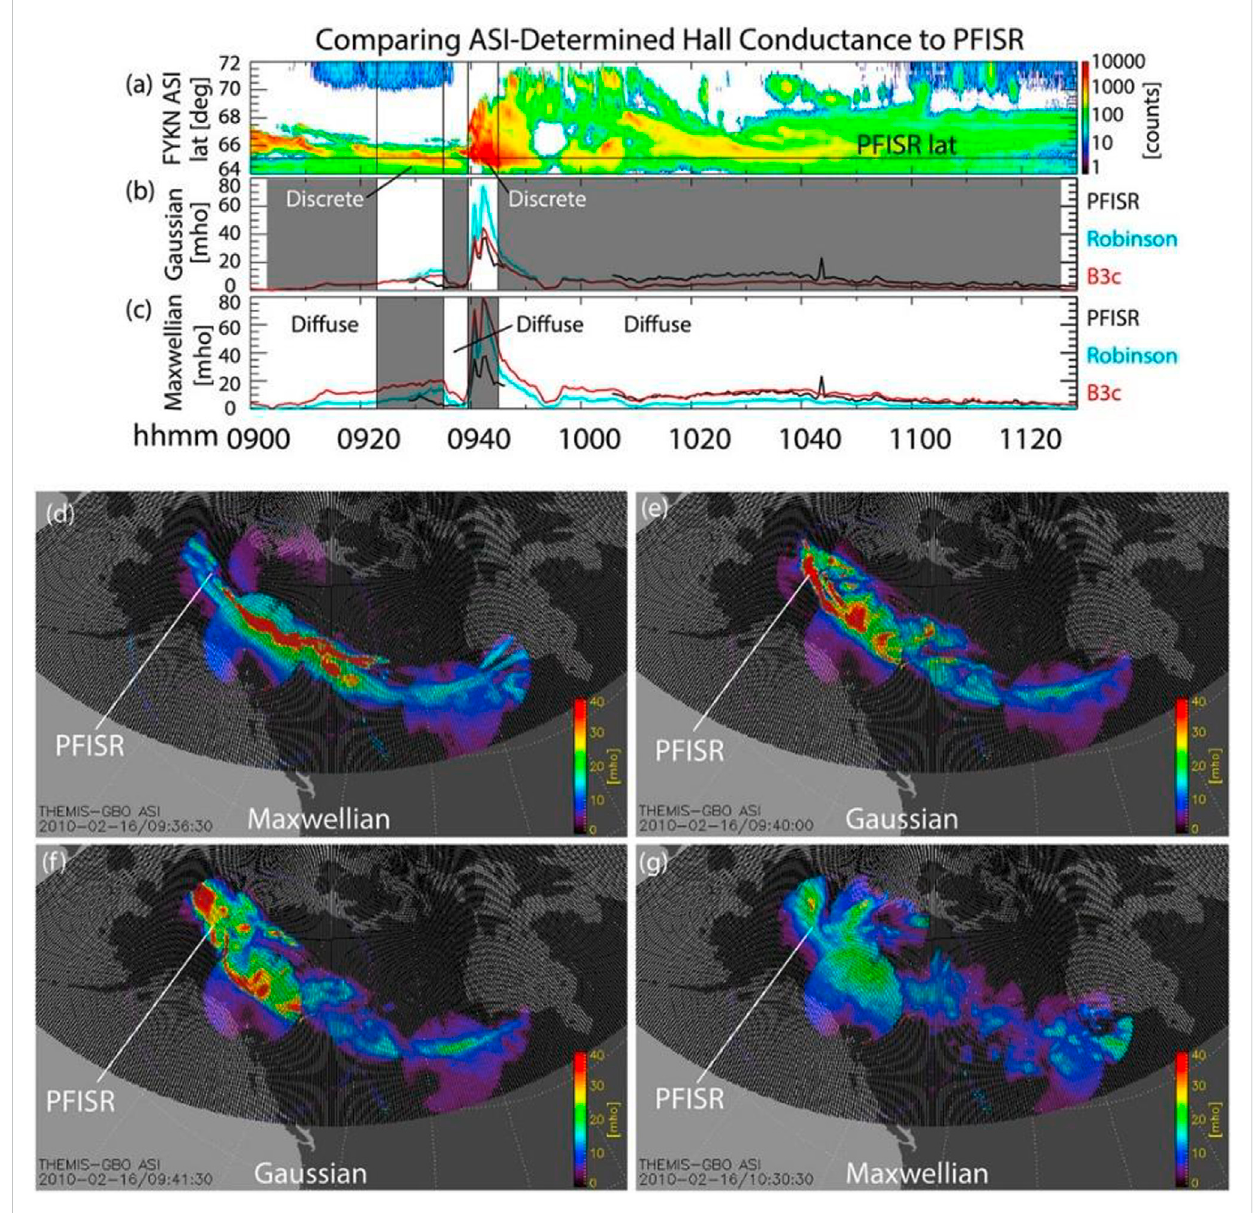
FIGURE 8 From Gabrielse et al. (2021). (A) Keogram of white light counts at the Fort Yukon ASI at the Poker Flat Incoherent Scatter Radar (PFISR) longitude. PFISR latitude is marked with horizontal line. Comparing PFISR conductance ( σ ) (black) with ASI inputs to the Boltzmann Three Constituent (B3C) auroral transport code (Strickland et al., 1976; 1993) (red) and Robinson formulae (blue) for discrete aurora with an electron population described by a Gaussian distribution (B) anddiffuseauroradescribedbyaMaxwelliandistribution (C) .TheB3CversionhasagoodmatchwithPFISR. (D – G) are2Dplotsofthe Hall conductance determined by ASI inputs to